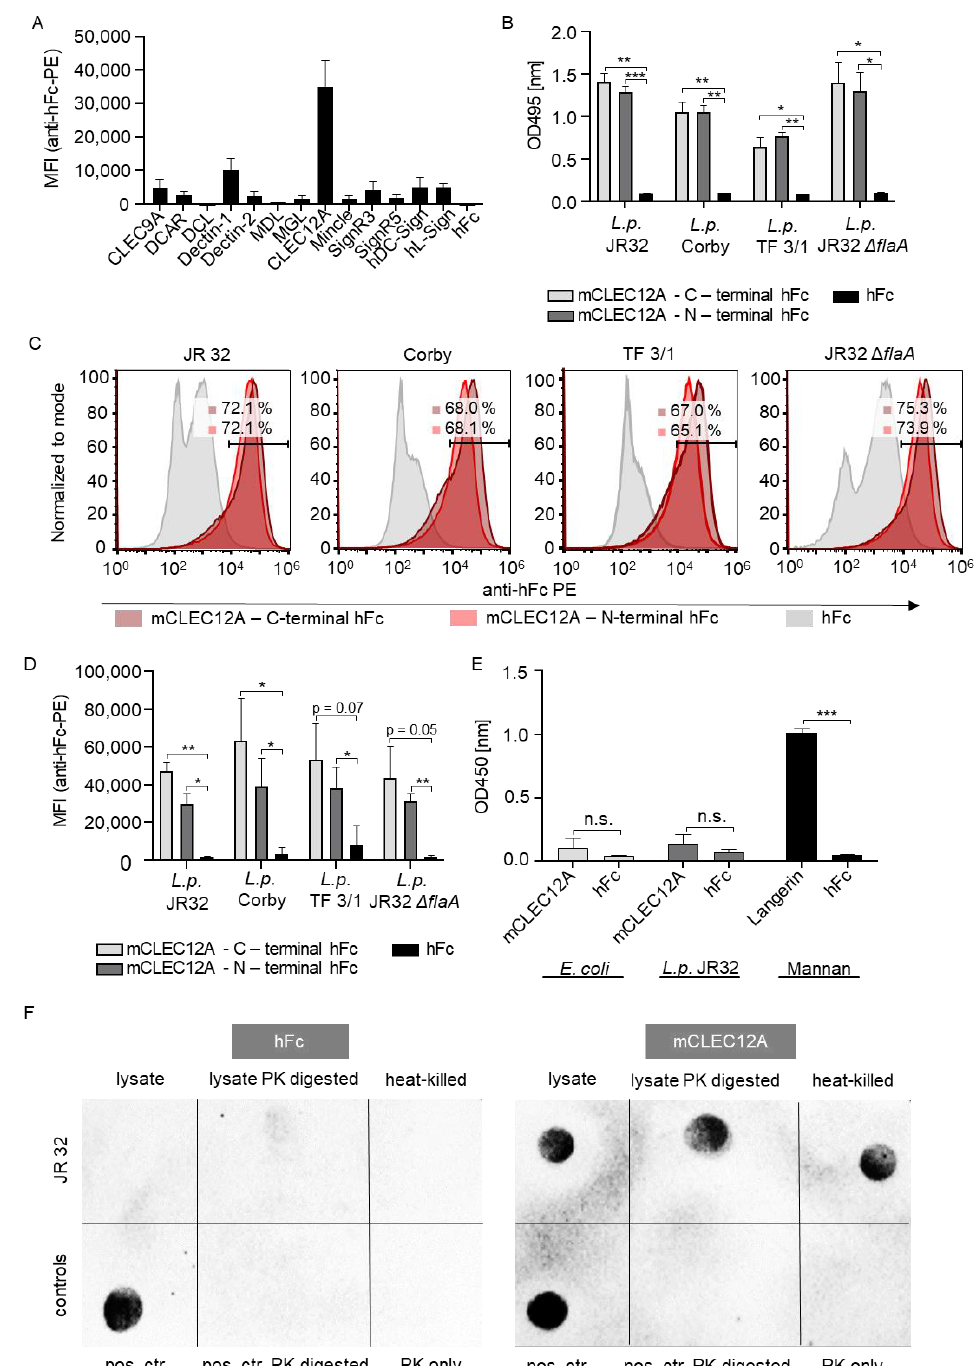
Figure 1. The murine CLEC12A-hFc fusion protein recognizes L. pneumophila ( A ) Flow cytometry- based binding study of a comprehensive CLR-Fc fusion protein library to L. pneumophila wild-type strain JR32. A PE-conjugated anti-hFc antibody was used for CLR detection. The results are presented as the mean fluorescence intensities (MFI). ( B ) ELISA-based binding study using the L. pneumophila strains JR32, Corby, TF 3/1 and JR32 ∆ flaA . C-terminal hFc (N-CTLD-hFc-C) and N-terminal hFc (N-hFc-CTLD-C) murine CLEC12A fusion proteins were incubated with the respective strains, and binding was detected using an anti-hFc HRP antibody. ( C , D ) Flow cytometry-based binding study using the L. pneumophila strains JR32, Corby, TF 3/1 and JR32 ∆ flaA . The binding study was